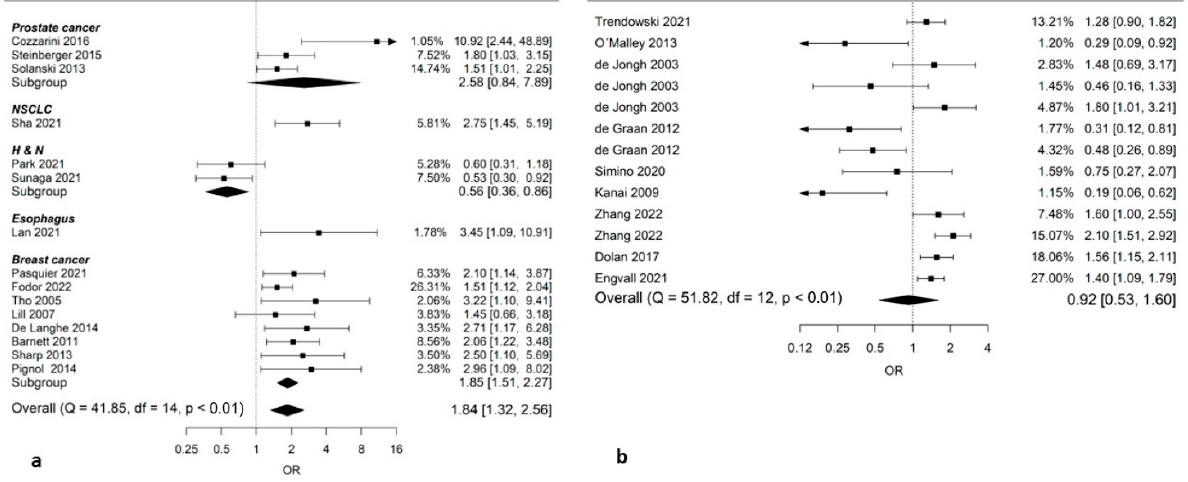
Figure 4. Forest plots on pooled Odds Ratios (ORs) on smoking during treatment and toxicity. ( a ) Smoking during radiotherapy and toxicity; ( b ) smoking during chemotherapy and toxicity. OR > 1 indicates higher risk for toxicity during treatment, whereas HR < 1 indicates lower risk. Comparison group is non-smokers (former or never). Abbreviations : NSCLC, non-small-cell lung cancer; H&N, head and neck